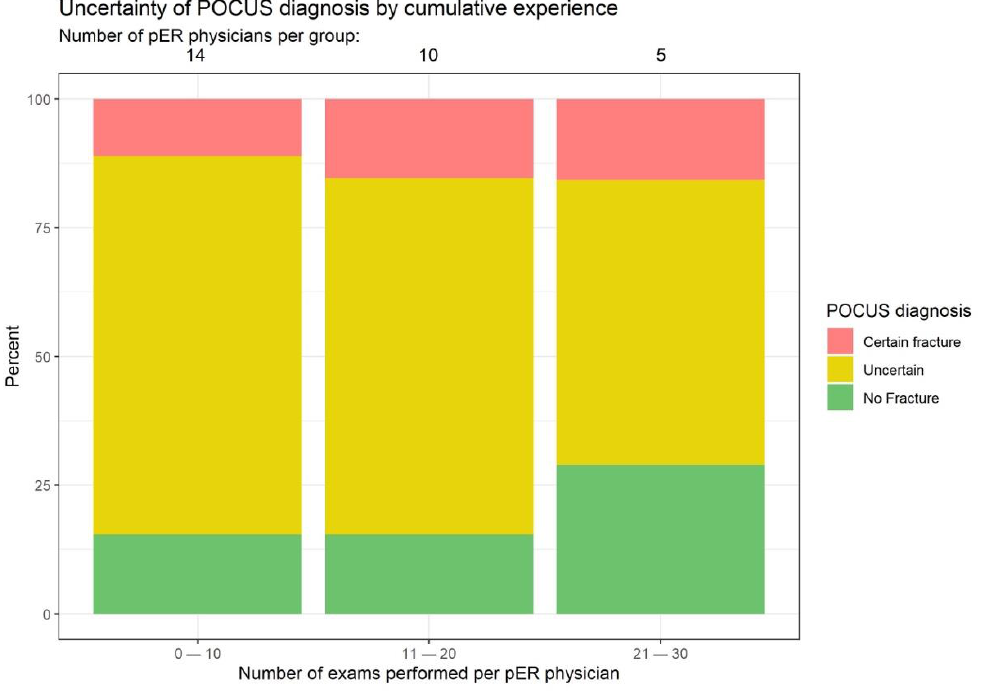
Figure 5. Learning progression. Red: positive fracture sign in POCUS and X-ray without subjective need for an X-ray; green: exclusion of fracture in POCUS and X-ray without subjective need for an X-ray; yellow: results with subjective need for an X-ray.